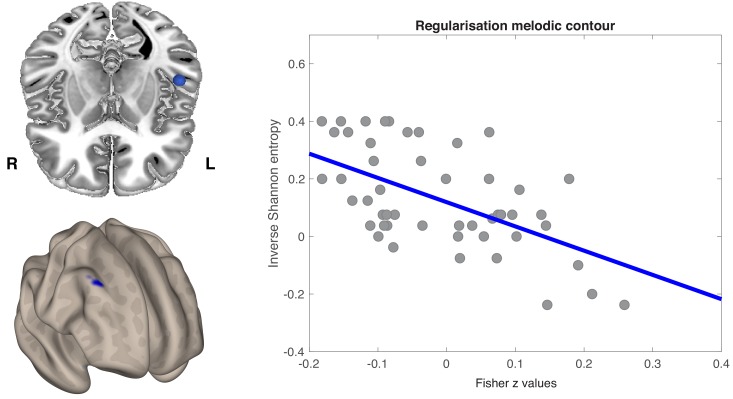
Seed-to-voxel regression analysis was conducted over the whole brain.(a) Axial view of the left anterior STG (blue sphere) (top) and the voxel-wise FC correlation map (Fisher Z-transformed) (bottom). One cluster was identified by non-parametric permutation tests as showing a significant negative correlation between temporo-frontal connectivity values and melodic regularization (p<0.05, cluster-mass FWE corrected). (b) Pearson’s product moment correlation (r) between melodic regularization and mean FC connectivity between seed and all significant voxels in the frontal cluster (r = −0.58; p<0.001). Each point on a scatterplot is one participant (N = 51).